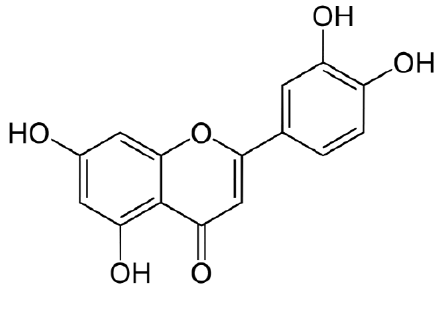
Figure 1. The structure of luteolin isolated from perilla ( P. frutescens ) leaves.